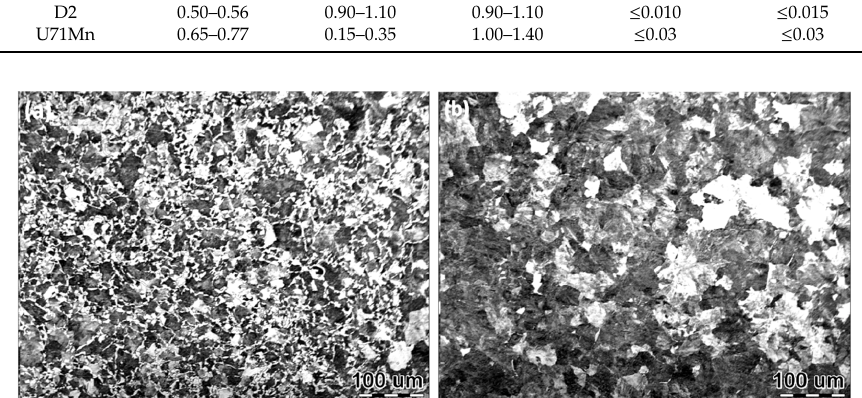
Figure 1. The original microstructure of wheel and rail samples. ( a ) D2 wheel steel and ( b ) U71Mn rail steel.